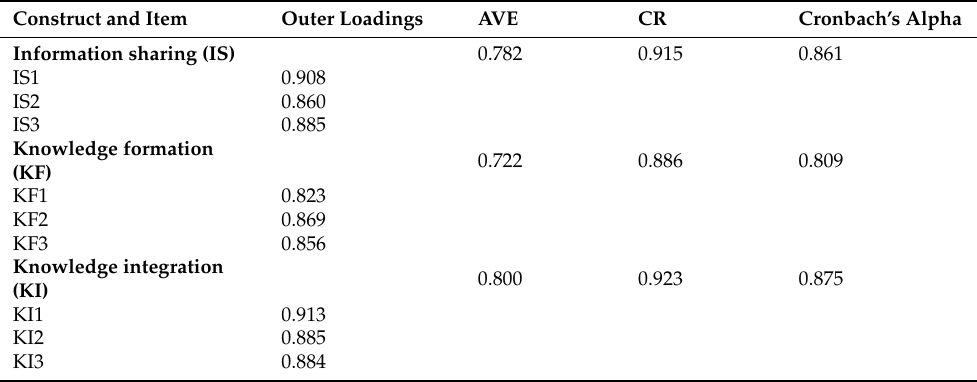
Table 4. Factor loadings, AVE, CR, and Cronbach’s alpha of